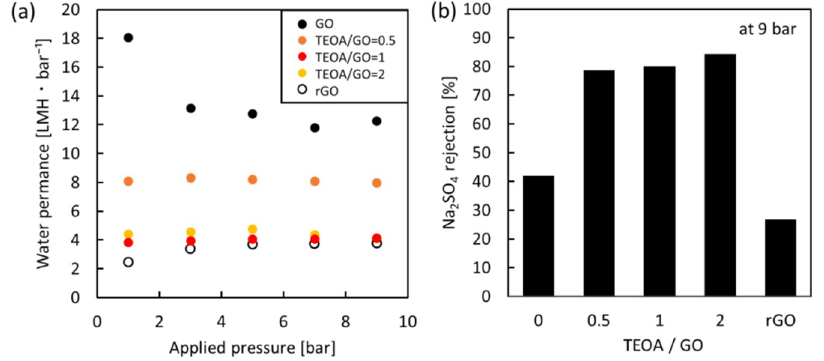
Figure 8. ( a ) Pressure-dependent water permeance of the unmodified GO membranes, GO-TEOA membrane fabricated with different TEOA/GO ratios and the rGO membrane; ( b ) Na 2 SO 4 rejection of each membranes at 9 bar.